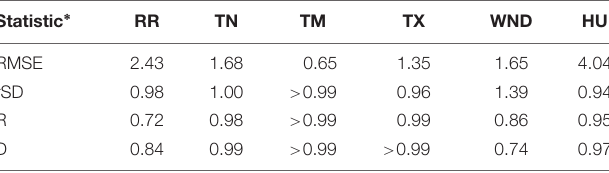
TABLE 4 | Descriptive statistical analysis for the meteorological variables comparing reanalysis and interpolated station data: precipitation (RR), mean temperature (TM), wind speed (WND), and relative humidity